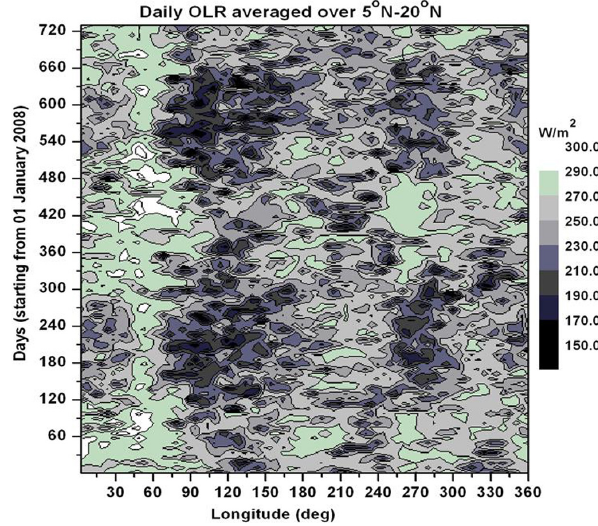
Fig. 5. Time–longitude cross sections of the OLR (Wm − 2 ) aver- aged over 5 ◦ N–20 ◦ N for the observational period 1 January 2008– 31 December